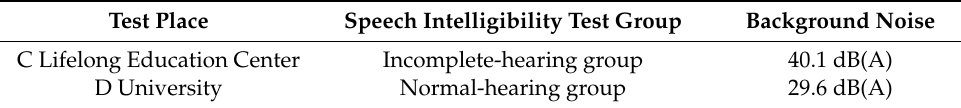
Table 12. General information of speech intelligibility tests.